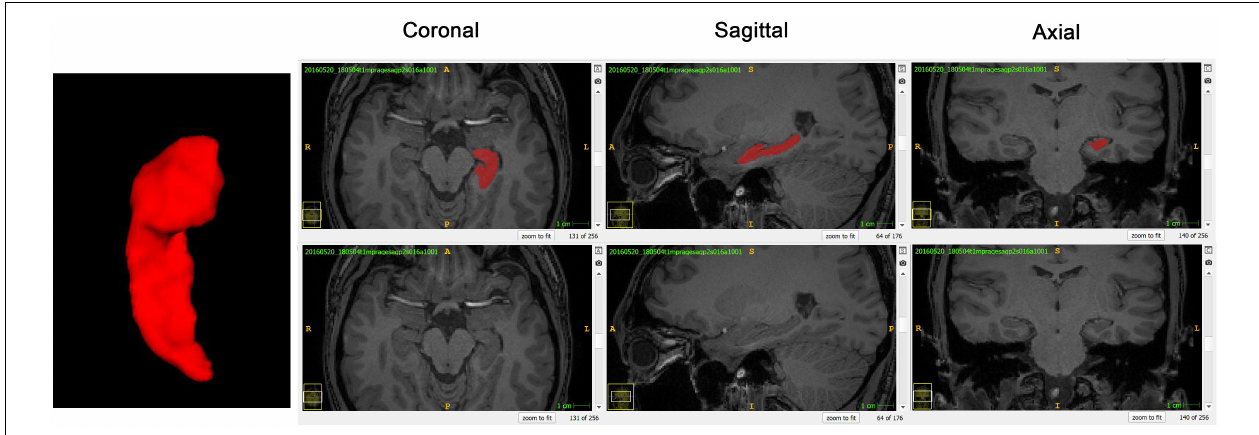
FIGURE 1 | A normal sighted subject was taken as the example to show segmentation and surface reconstruction of the left hippocampal formation (HF) using the ITK-SNAP software. The 3D reconstructed HF and the coronal, sagittal, and axial planes were displayed from left to right, respectively.